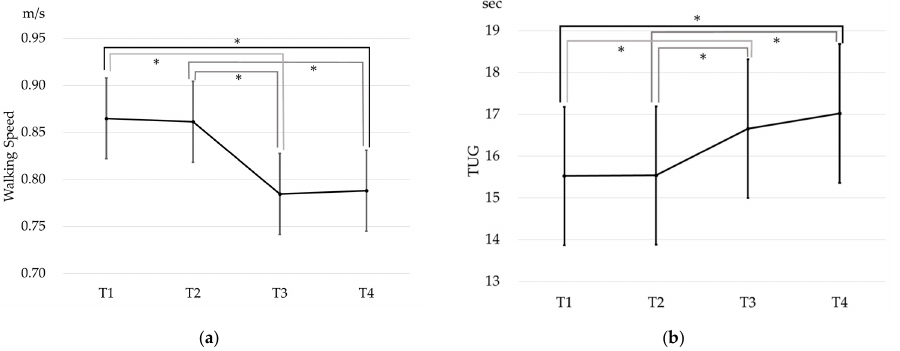
Figure 2. The physical data at each time period. ( a ) The mean walking speed at each time period (95% confidence interval); ( b ) the mean TUG score at each time period (95% confidence interval). *